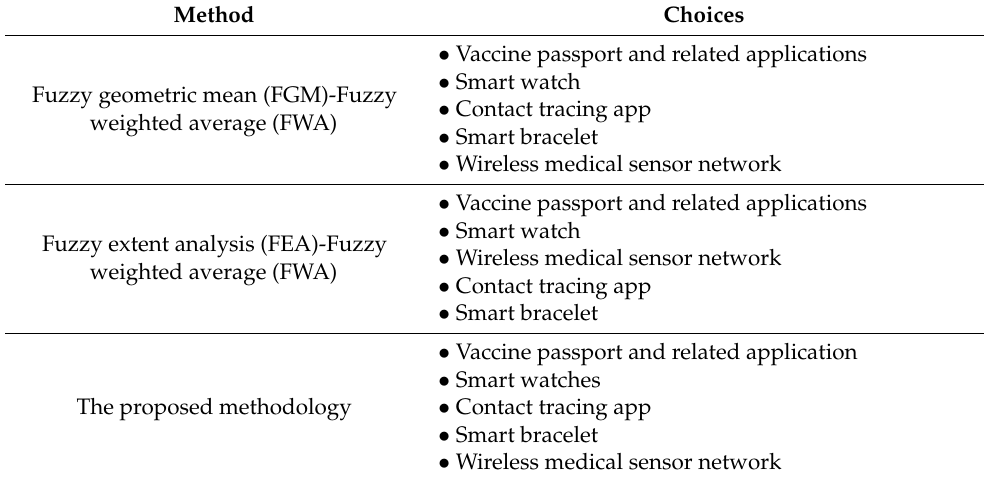
Table 8. Five smart technology applications were selected using various methods.